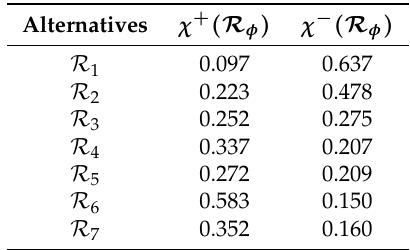
Table 11. Positive and negative outranking